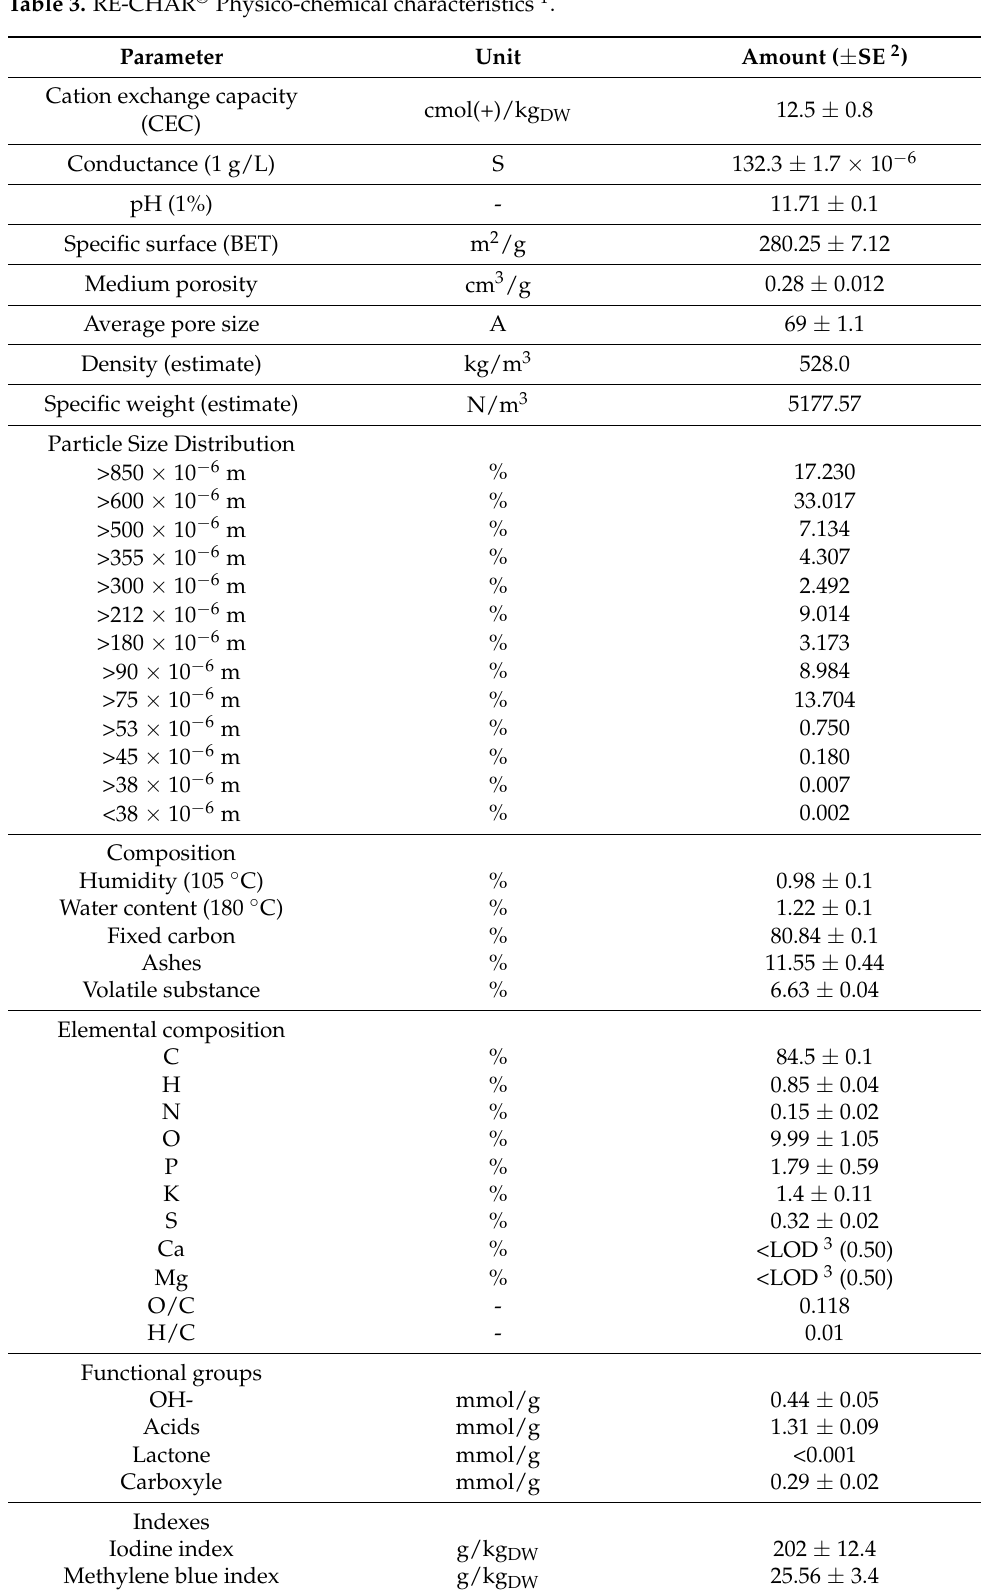
Table 3. RE-CHAR ® Physico-chemical characteristics 1